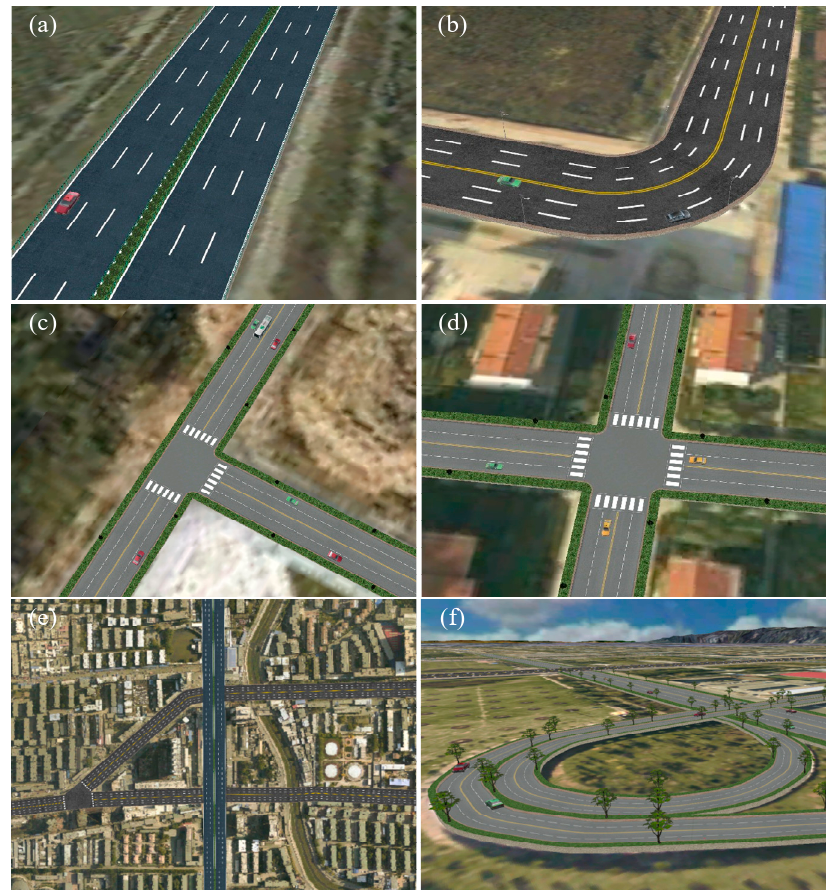
Figure 13. Different road modeling: ( a ) Straight normal road modeling; ( b ) simple road corner modeling; ( c ) three-way intersection modeling; ( d ) four-way intersection modeling; ( e ) grade separation modeling; ( f ) expressway ramp modeling.